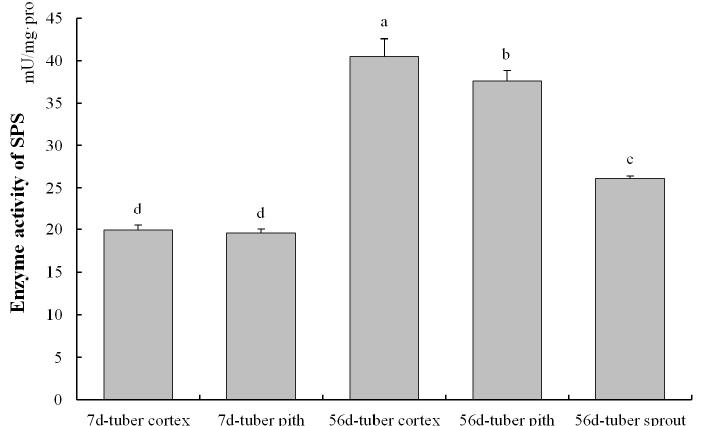
Figure 3. SPS enzyme activity in different tuber tissues at the dormant and sprouting stages. The error bar represents the standard error, calculated through three biological replicates. The uniformity of letters denotes a lack of disparity in SPS enzyme activity between two distinct tissues. Contrarily, the presence of different letters illustrates significant difference at a statistical threshold of p < 0.05. For example, the marked discrepancy between the SPS enzyme activity of the ‘56d-tuber cortex’ and ‘56d-tuber pith’ groups is delineated by the use of letters ‘a’ and ‘b’.